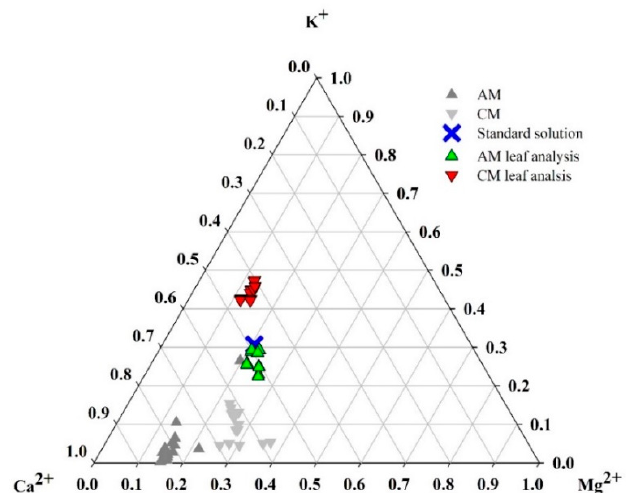
Figure 11. Nutrient balance changes in the rockwool substrates and dried leaves using the conventional (CM) and alternative (AM) nutrient-replenishment methods.